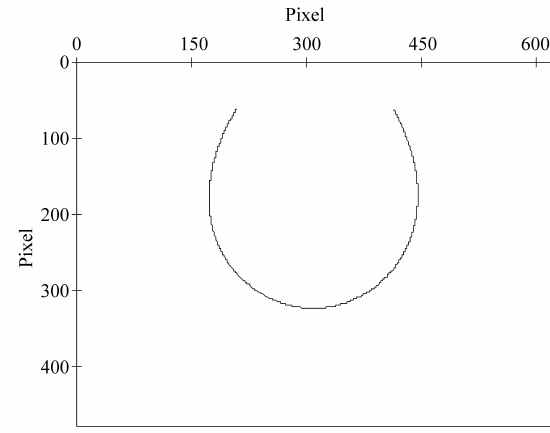
Figure 4a. Digitized drop.